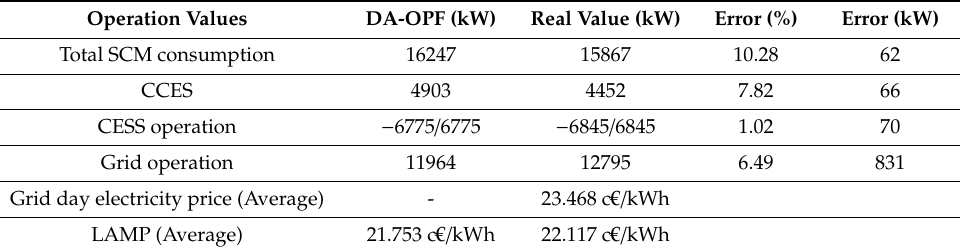
Table 5. One-day OPF simulation (summer day).